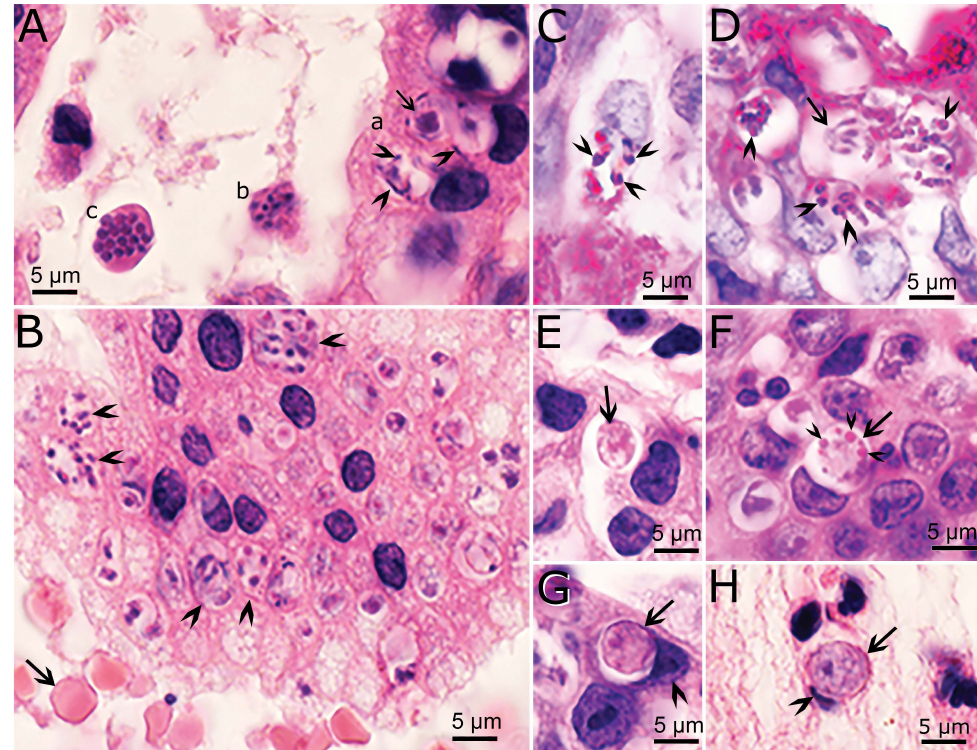
Figure 2. Stages of Cyclospora cayetanensis in the gallbladder of an immunosuppressed patient. ( A , B , E – H ) Hematoxylin and eosin stain. ( C , D ) Periodic acid Schiff (PAS) reaction, counter-stained with hematoxylin. Bar applies to all figures. ( A ) The glandular epithelium is on the right and lumen on the left. (a) Three microgamonts in epithelial cells. Note peripherally located microgametes (arrowheads) around a large residual body (arrow). (b, c) Schizonts free in the lumen of a gland. Note cross section (c) of merozoites in a schizont. ( B ) Desquamated epithelium in lumen of a gland. Note numerous schizonts (arrowheads) and red blood cells (arrow) for size comparison. ( C ) A schizont with PAS-positive (arrowheads) merozoites. ( D ) Several schizonts with variable PAS-positive granules (arrowheads). Arrow points to a PAS-negative schizont that has merozoites attached to a residual body (arrow). ( E ) An early macrogamont (arrow). ( F ) A late macrogamont (arrow) with eosinophilic wall-forming bodies (arrowheads). The host cell nucleus is indented. ( G ) An intracellular oocyst (arrow) in the epithelium. Note indented host cell nucleus (arrowhead). ( H ) An oocyst (arrow) free in lumen of gallbladder. Arrowhead points to indented host cell nucleus